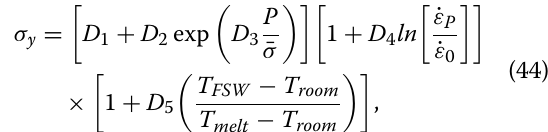
Figure 3 The procedure of the generation of the heat during